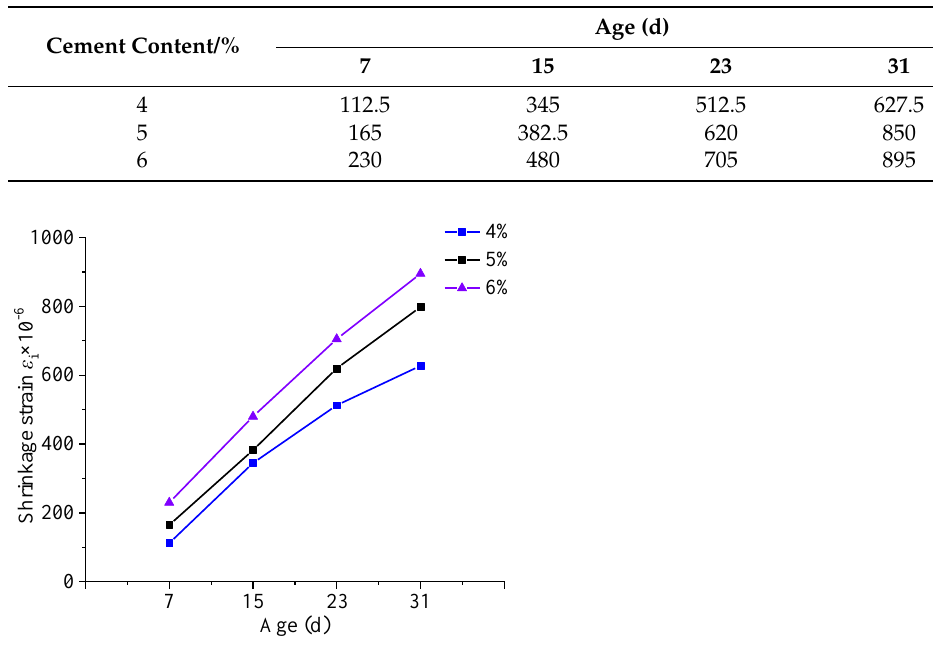
Figure 19. Relationship between dry shrinkage strain and age of cement stabilized gangue.